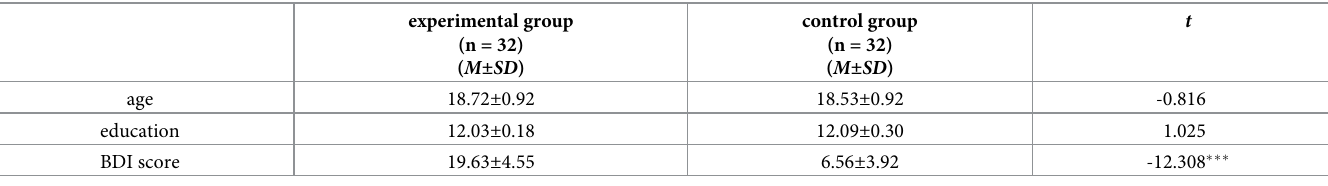
Table 1. Characteristics of the experimental and control